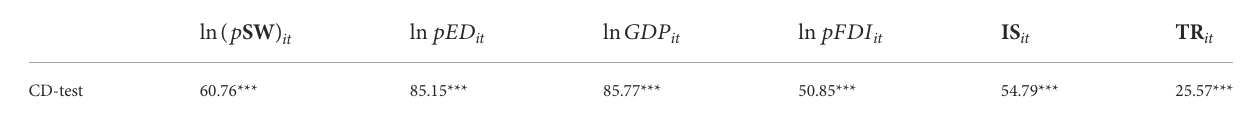
TABLE 5 Results from cross-sectional independence test.